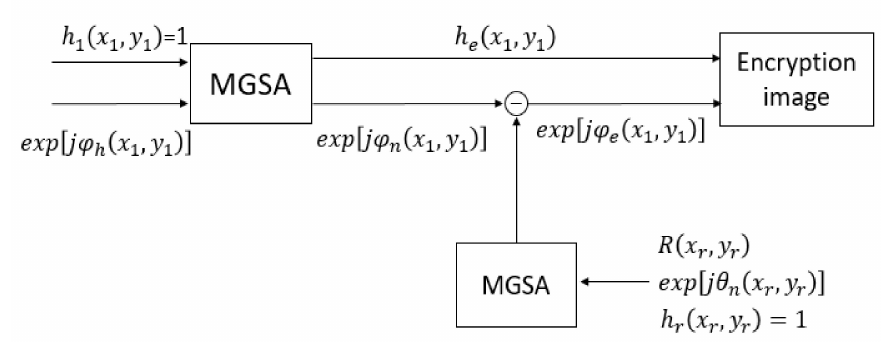
Figure 5. Encryption flow chart.